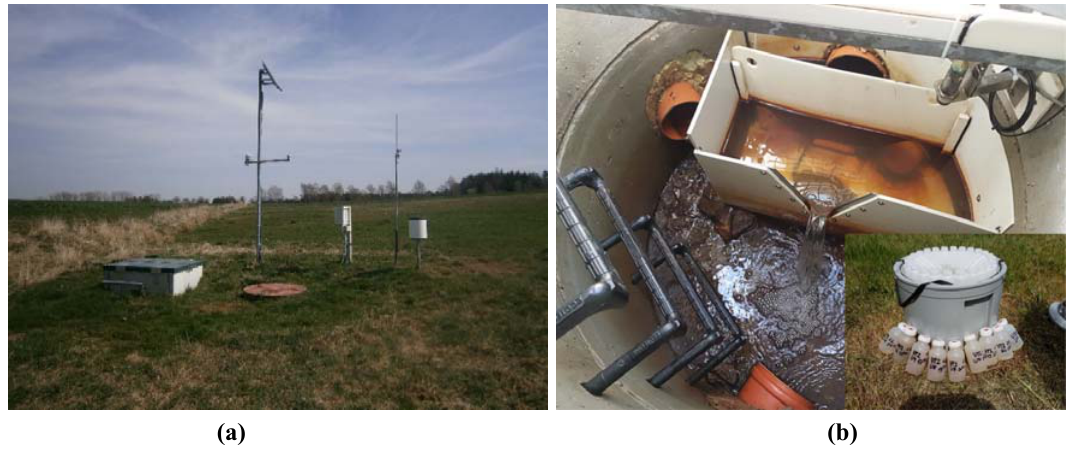
Figure 2. An example of sampling site equipment. (a) : site Š2; (b) : site VP2